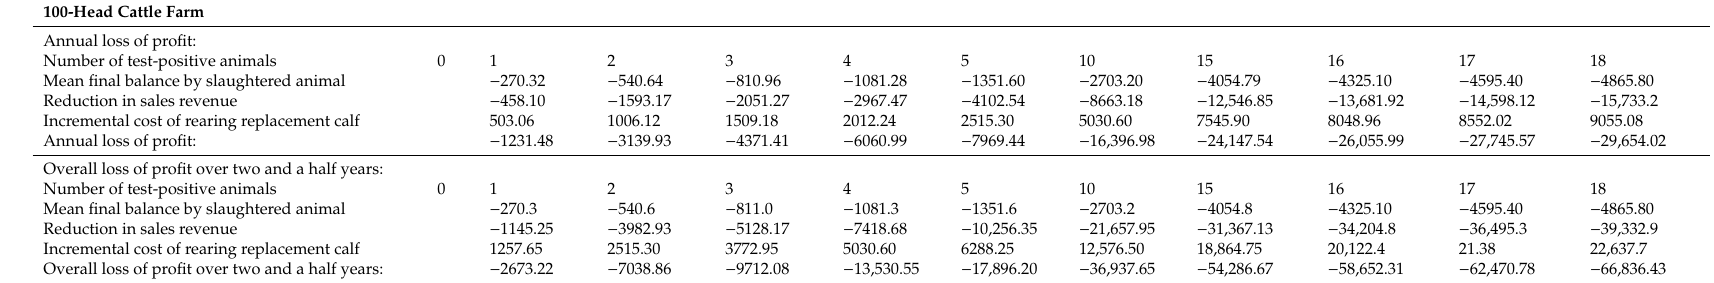
Table 11. Loss of profit on a farm with 100 head of cattle.